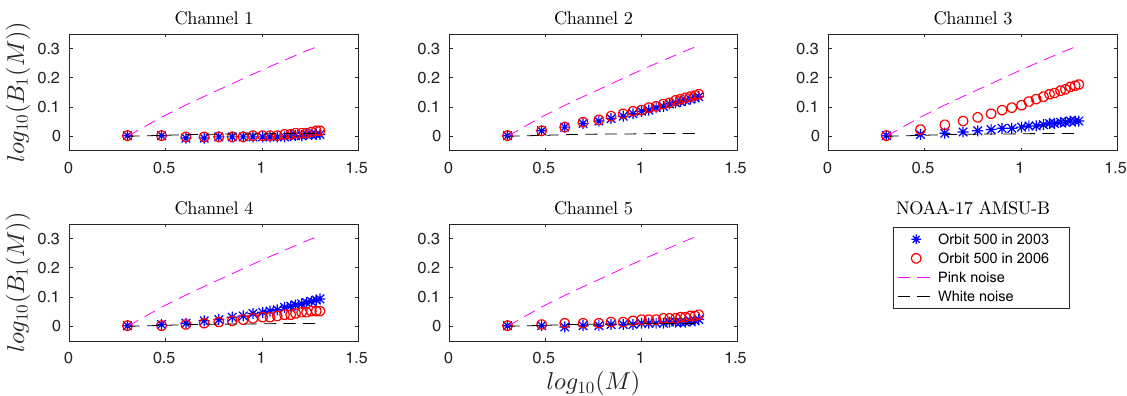
Figure 4. The bias functions B 1 (M) per channel for the orbits 500 of the year 2003 and the year 2006 for AMSU-B on NOAA-17.